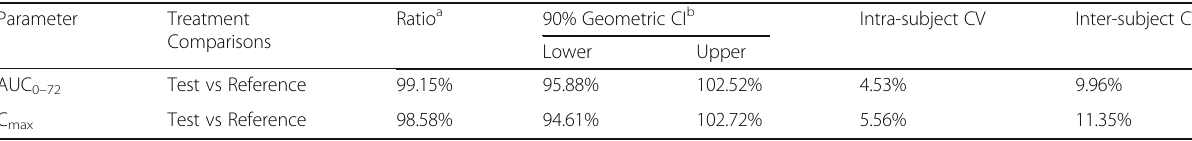
Table 3 Ratios and 90% Geometric Confidence Intervals